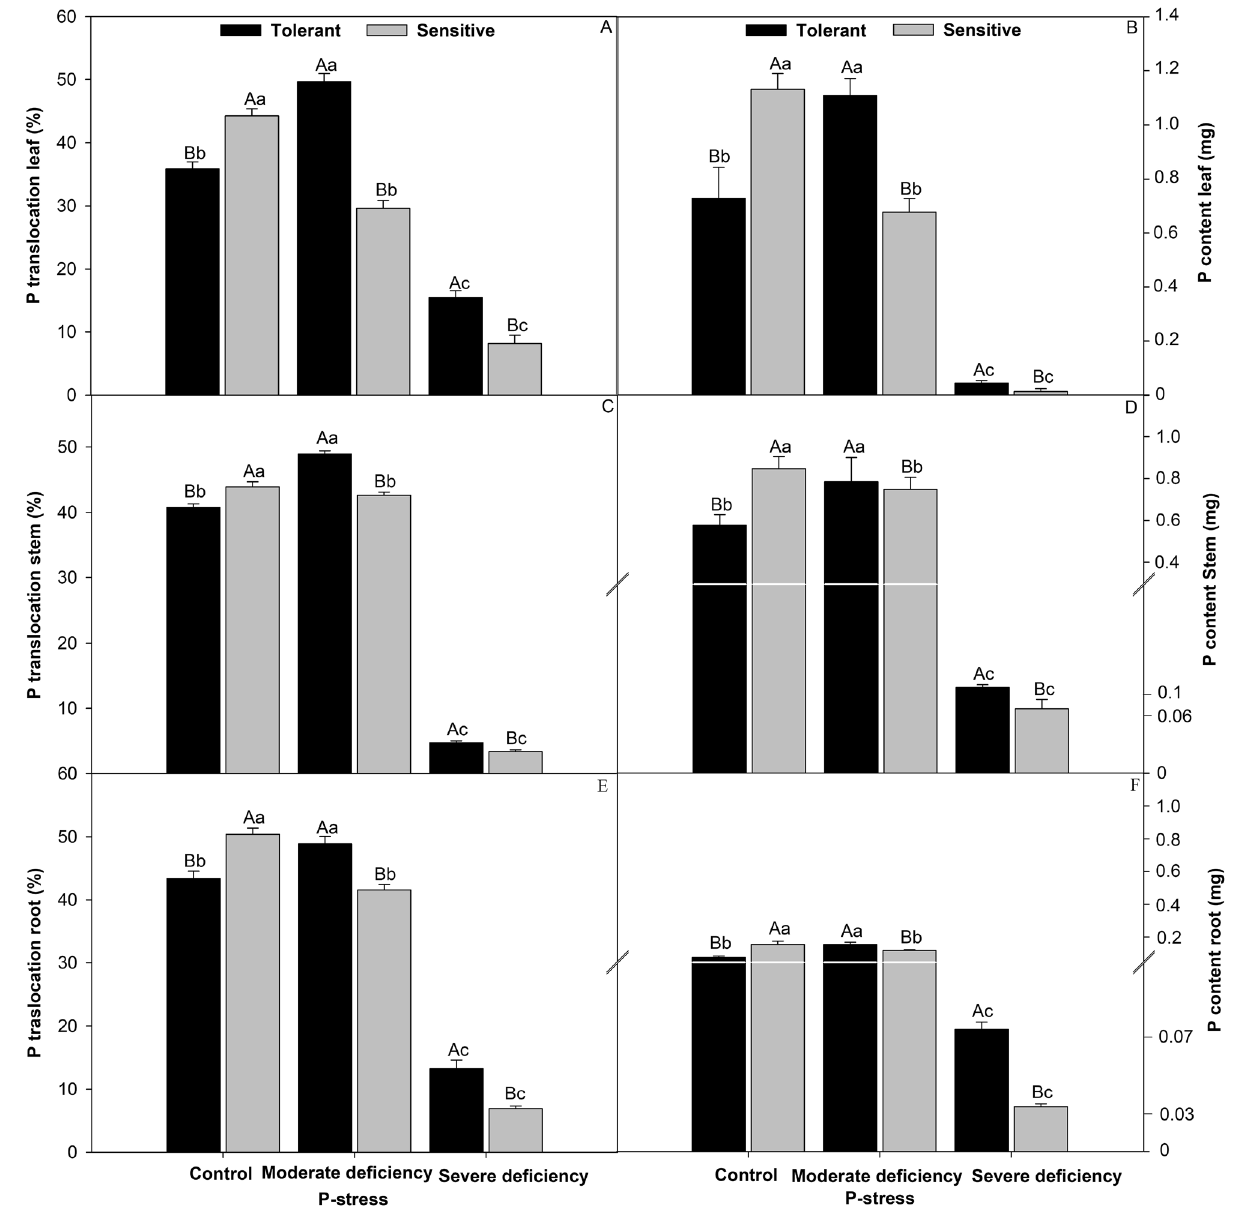
Figure 4. The P-translocation leaf ( A ), P-content leaf ( B ), P-translocation steam ( C ), P-content steam ( D ), P-translocation root ( E ), and P-content root ( F ) in cultivars tomato treated P-stress. Columns with different capital letters compare cultivars (tolerant and sensitive) between P stress levels (control, moderate deficiency, and severe deficiency). Lowercase letters compare cultivars (tolerant and sensitive) with the same color as a function of P stress levels (control, moderate deficiency, and severe deficiency). Different letters differ by the Scott–Knott test (P < 0.05). Columns corresponding to means of six repetitions and standard